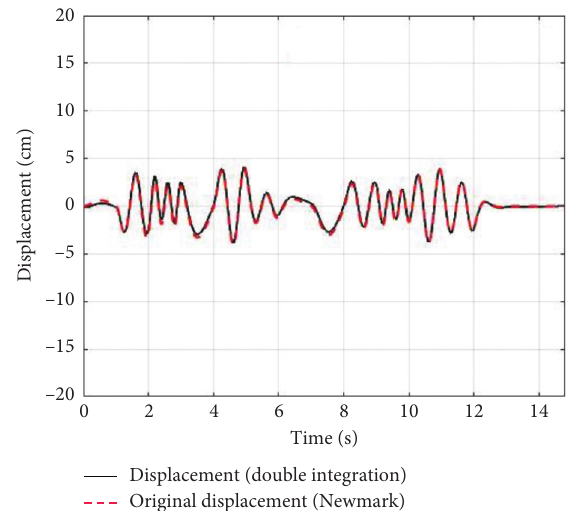
Figure 4: Pavement profile estimation using the proposed SMND approach (no noise included).